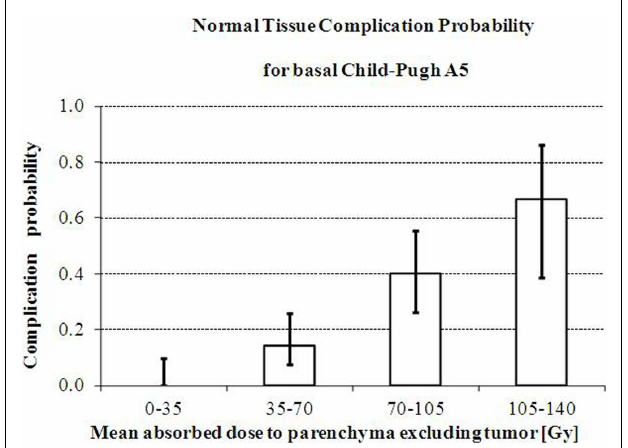
FIGURE 3 | Increase of risk of liver decompensation with mean absorbed dose . Increase of the observed risk of liver decompensation with whole parenchyma mean absorbed dose in intermediate/advanced HCC patients with Basal Child-Pugh A5 treated with glass microspheres. Reprinted with permission by Minerva Medica from Quarterly Journal of Nuclear Medicine Molecular Imaging